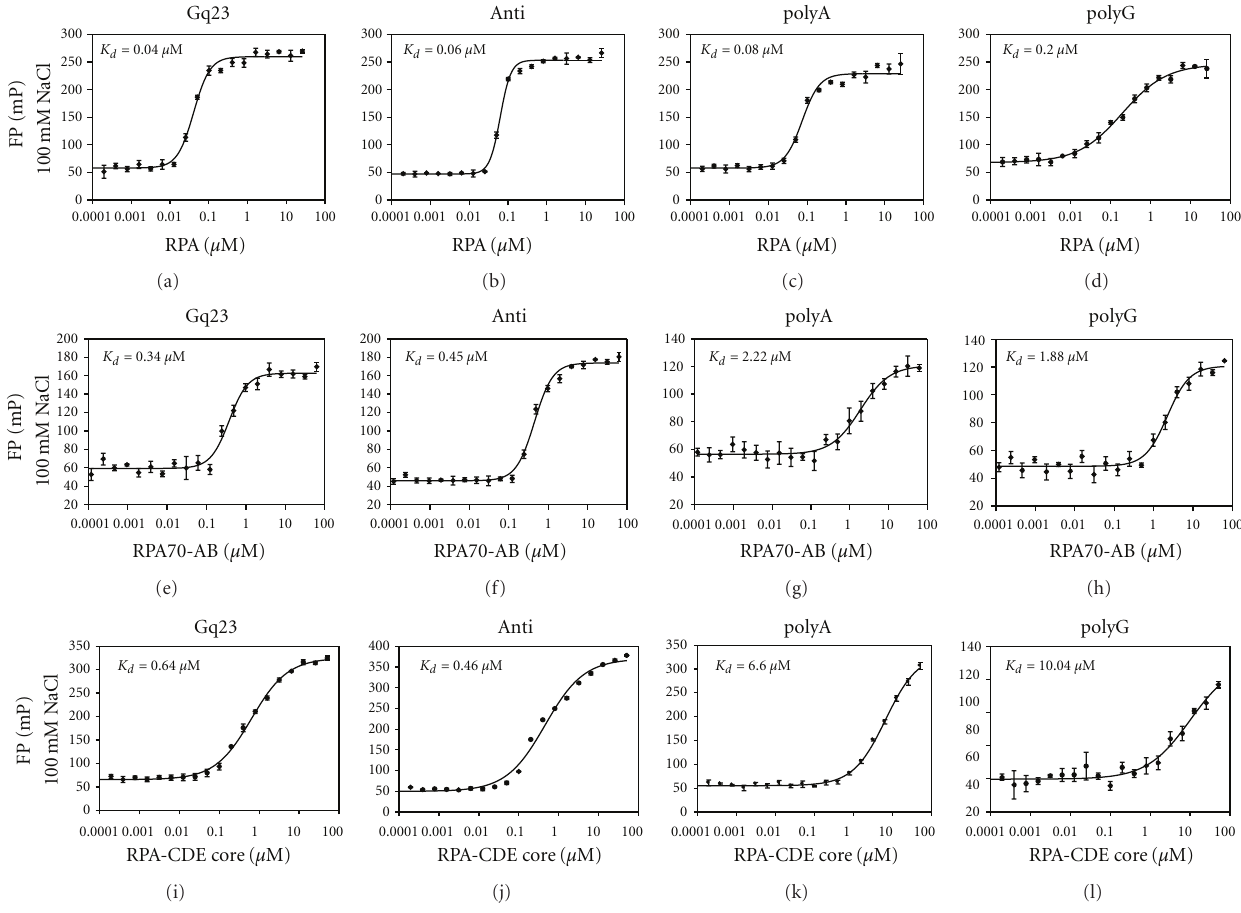
Figure 4: FP ssDNA-binding assays for RPA, RPA-AB, and RPA-CDE-core at 100 mM NaCl. Representative binding isotherms are shown. (a)–(d) RPA, (e)–(h) RPA-AB, and (i)–(l) RPA-CDE-core. The ssDNA sequences (Gq23, Comp, polyA, or polyG) are displayed at the top of each column, and the protein construct is listed at the beginning of a row. For each FP reaction, 0.060 μ M of oligo was titrated with ∼ 0–50 μ M of protein, and a binding isotherm was generated. K d values for each experiment are listed on the top left of each binding